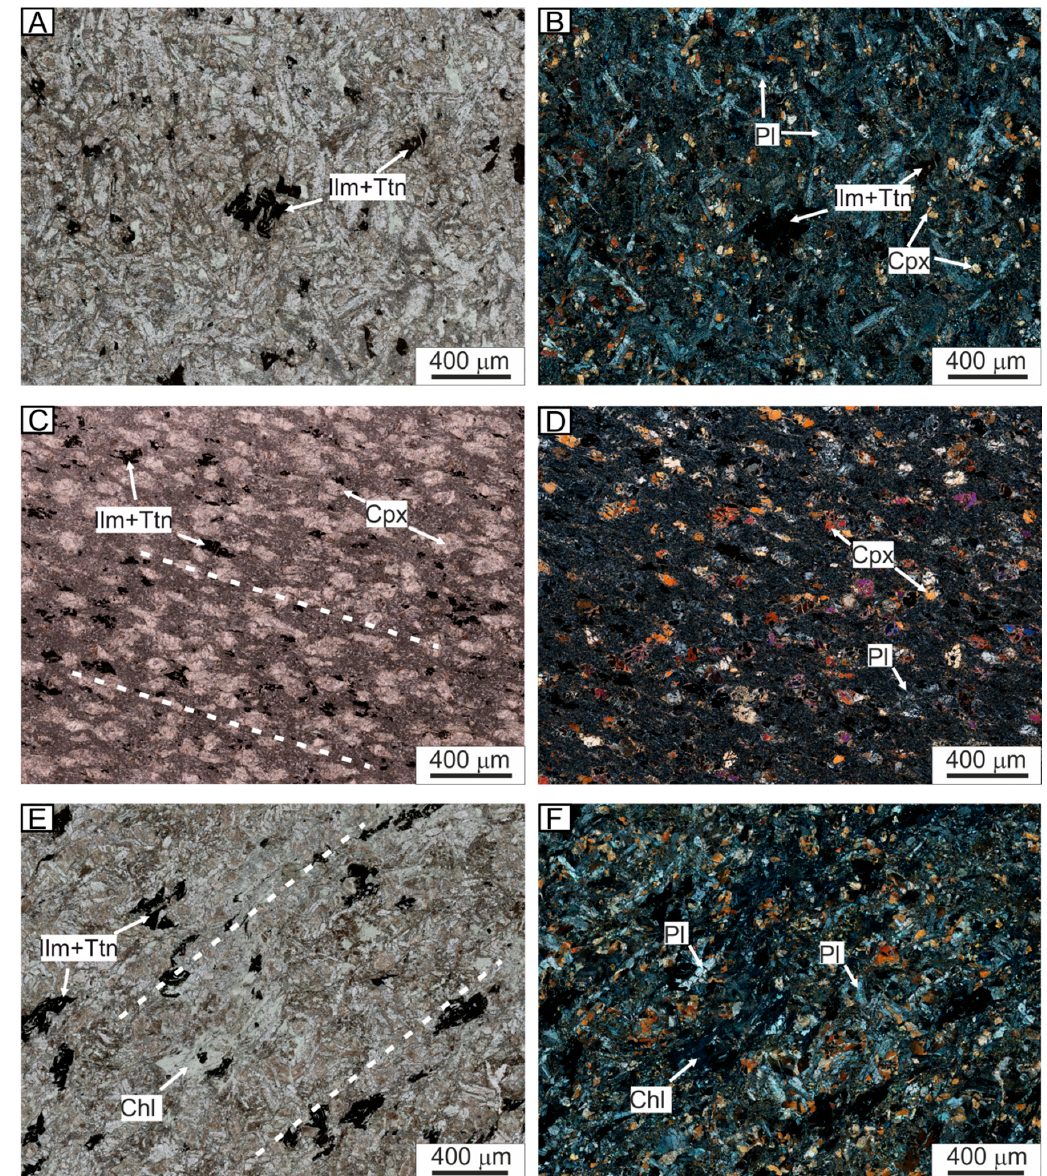
Figure 3. ( A , B ) Single and crossed-nicol photomicrographs of sample Dau5607 (site DAUST5), cropping-out on the coast 100 m SW of the outfall of the stream issuing from Daudmannsdalen. The randomly oriented feldspars are albitic-oligoclase with sericitized margins ( A ). The pyroxenes appear fragmented and many cases are partially to completely replaced by chlorite ( B ). The primary magmatic ilmenite/magnetite grains show no preferred orientation. ( C , D ) Single and crossed-nicol photomicrographs of metadolerite sample Dau1411 (site DAUST2). In this sample, there is a strong preferred orientation of the pyroxenes and the ilmenite/magnetite grains ( C ). Both show brittle deformation and a sinistral sense of shear. The feldspars are completely sericitized ( D ). ( E , F ) Single and crossed-nicol photomicrographs of the metadolerite sample Pro-63 (site DAUST6). In this sample, the ilmenite/magnetite grains are aligned in S1 foliation ( E ) and they are fragmented. The sample is traversed by NE–SW 2–3 mm wide chlorite bands derived from the alteration of the pyroxenes sheared fragments of which, along with those of feldspars, are entrained in the foliated matrix ( F ). Foliation planes marked by dashed line. Abbreviations: Chl—chlorite, Cpx—clinopyroxene, Ilm— ilmenite, Pl—plagioclase, Ttn—titanite.